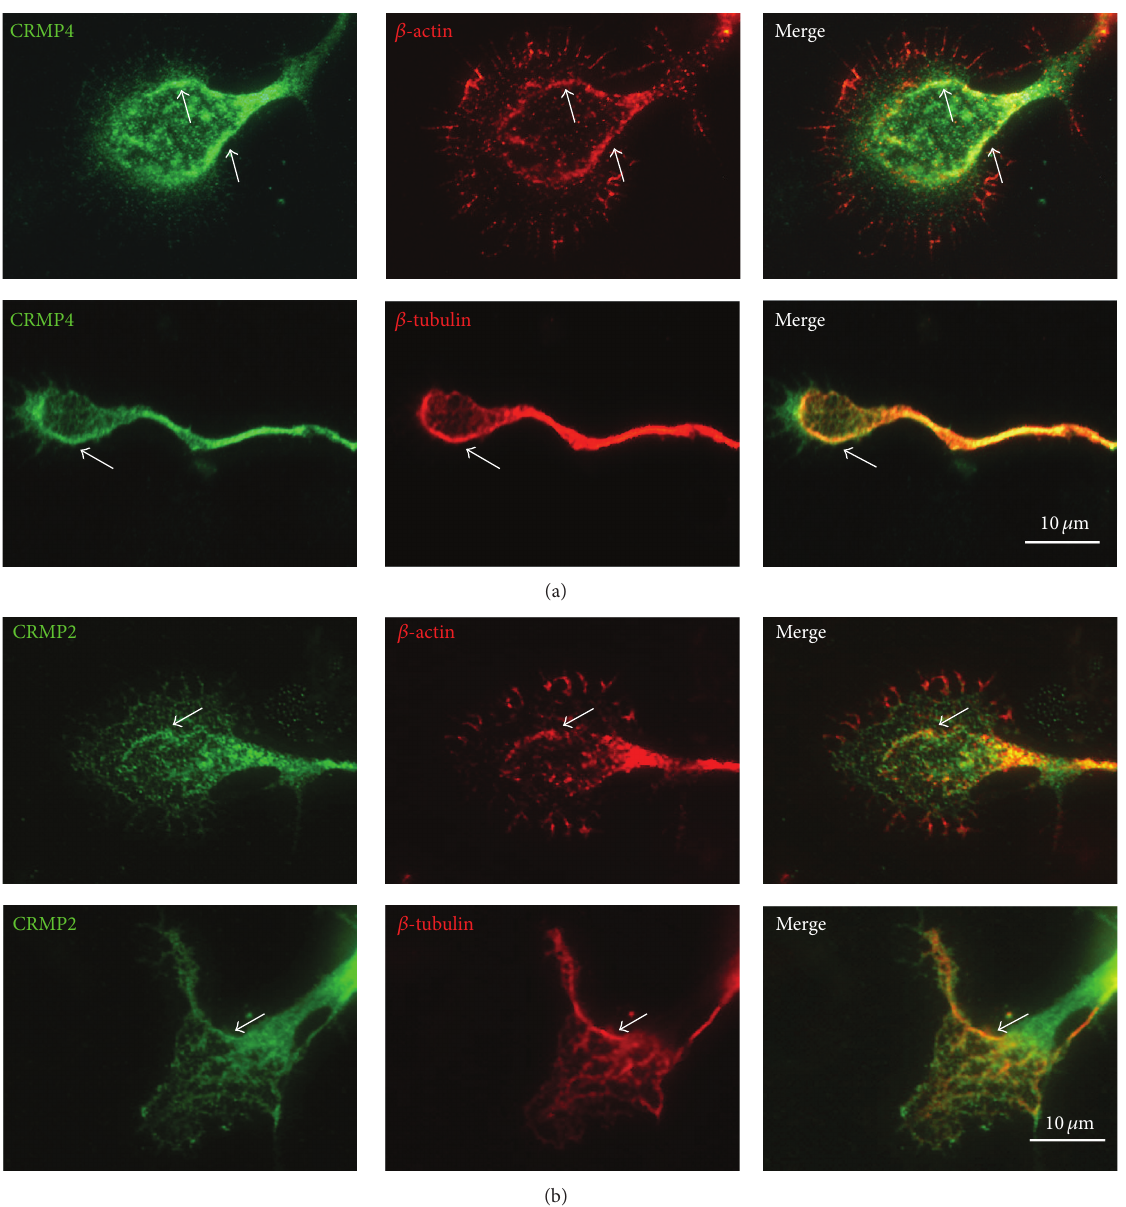
Figure 2: CRMP2 and CRMP4 colocalize with tubulin and actin in growth cones. (a) Anti-CRMP4, anti-tubulin, and anti-actin antibodies were used to detect endogenous proteins in the growth cones of hippocampal neurons. (b) Anti-CRMP2, anti-tubulin, and anti-actin antibodies were used to detect endogenous proteins in the growth cones of hippocampal neurons. Scale bar: 10 𝜇